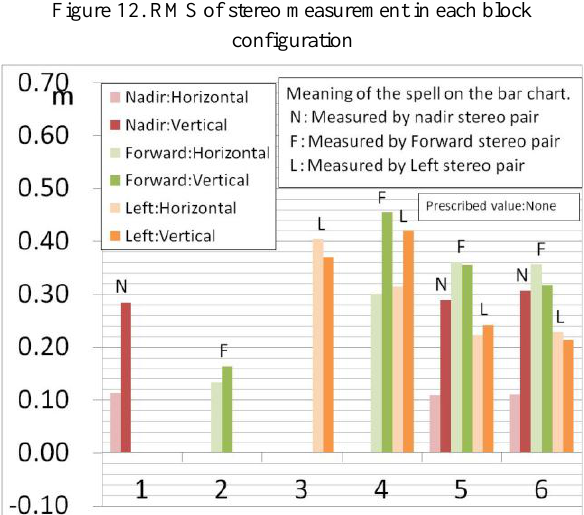
Figure 12. RMS of stereo measurement in each block configuration